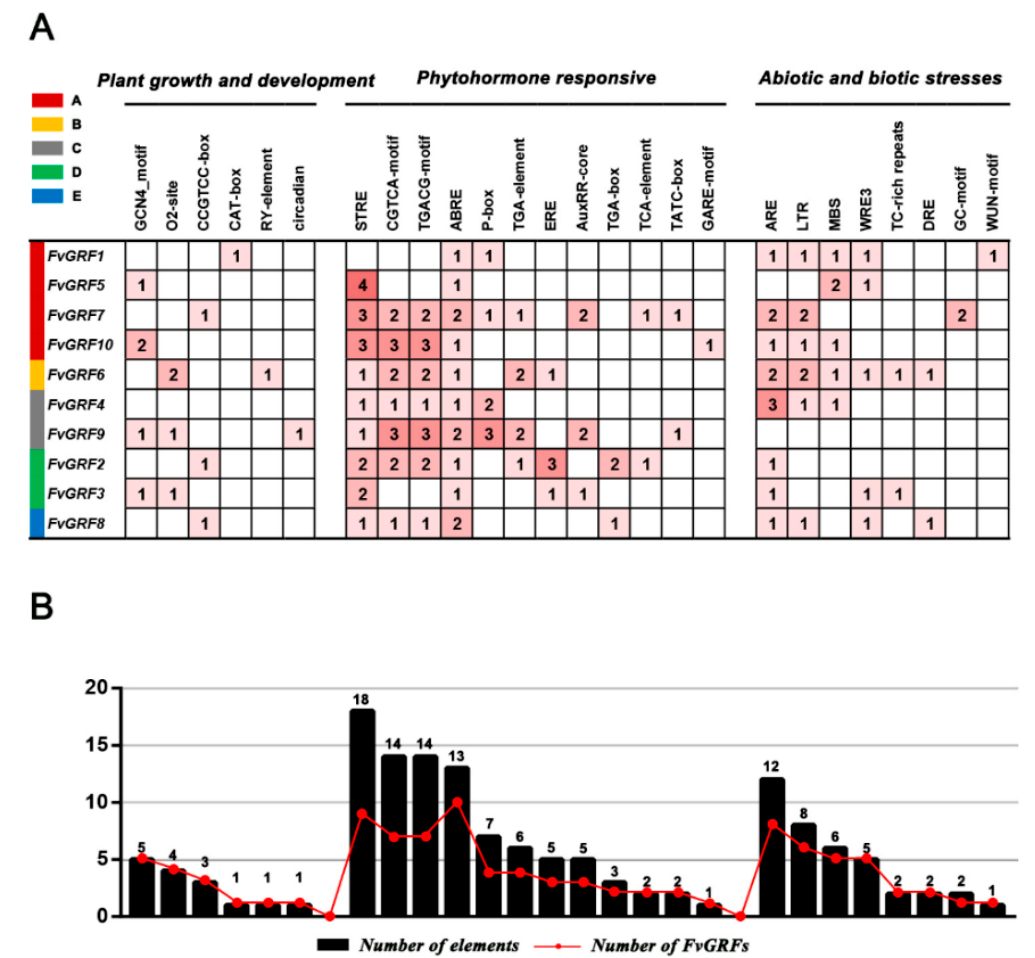
Figure 6. Analysis of cis -acting regulatory elements in the promoter of woodland strawberry GRF genes. ( A ) Number of each cis -acting element in the promoter region (1.5 kb upstream of the translation start site) of FvGRF genes. ( B ) Statistics for the total number of FvGRF genes, including the corresponding cis -acting element (red dot) and the total number of cis -acting elements in the FvGRF gene family (black box). On the basis of the functional annotation, the cis -acting elements were classified into three major classes: plant growth and development, phytohormone response, and abiotic and biotic stress